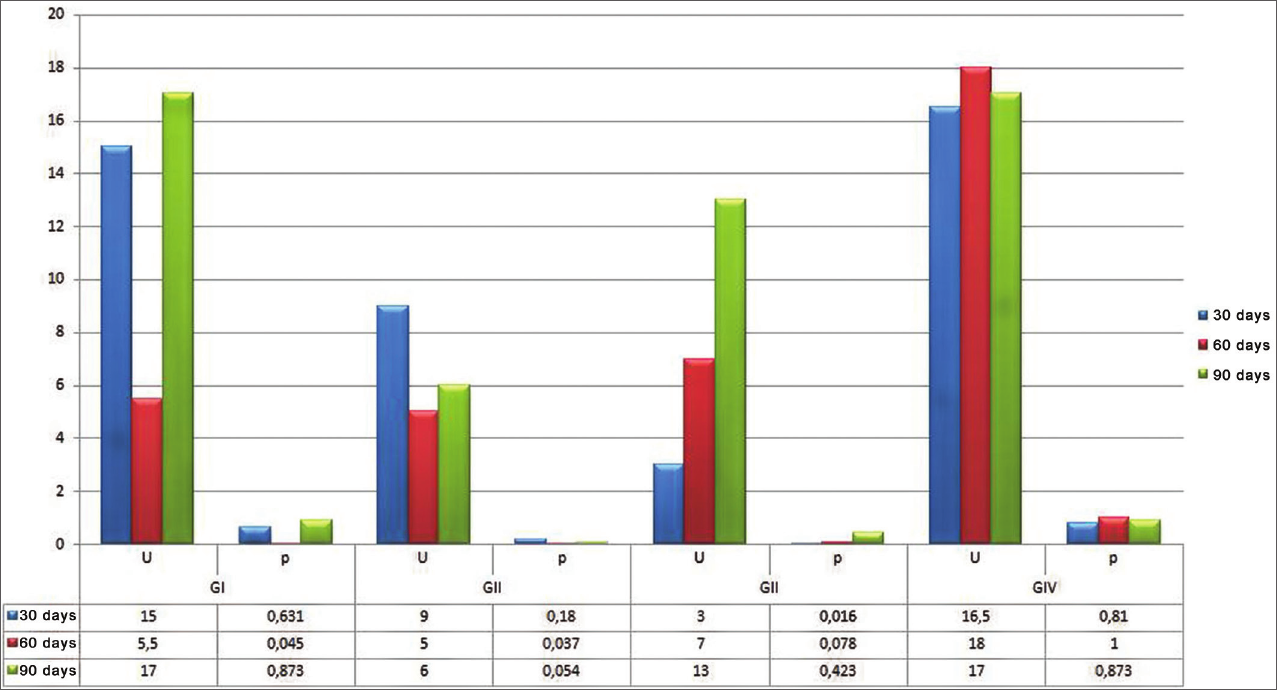
Chart 2. Histomorphometric assessment according to the test and control groups’ mean values, by evaluation time and according to the material tested. Blue: 30 days; Red: 60 days; and Green: 90